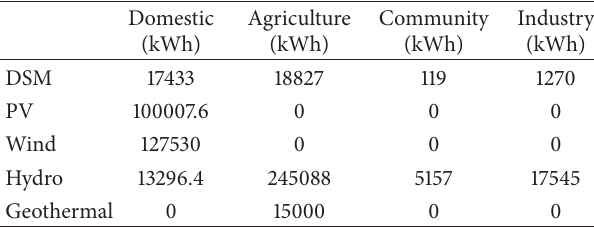
Table 3: Goal programming optimum solutions.